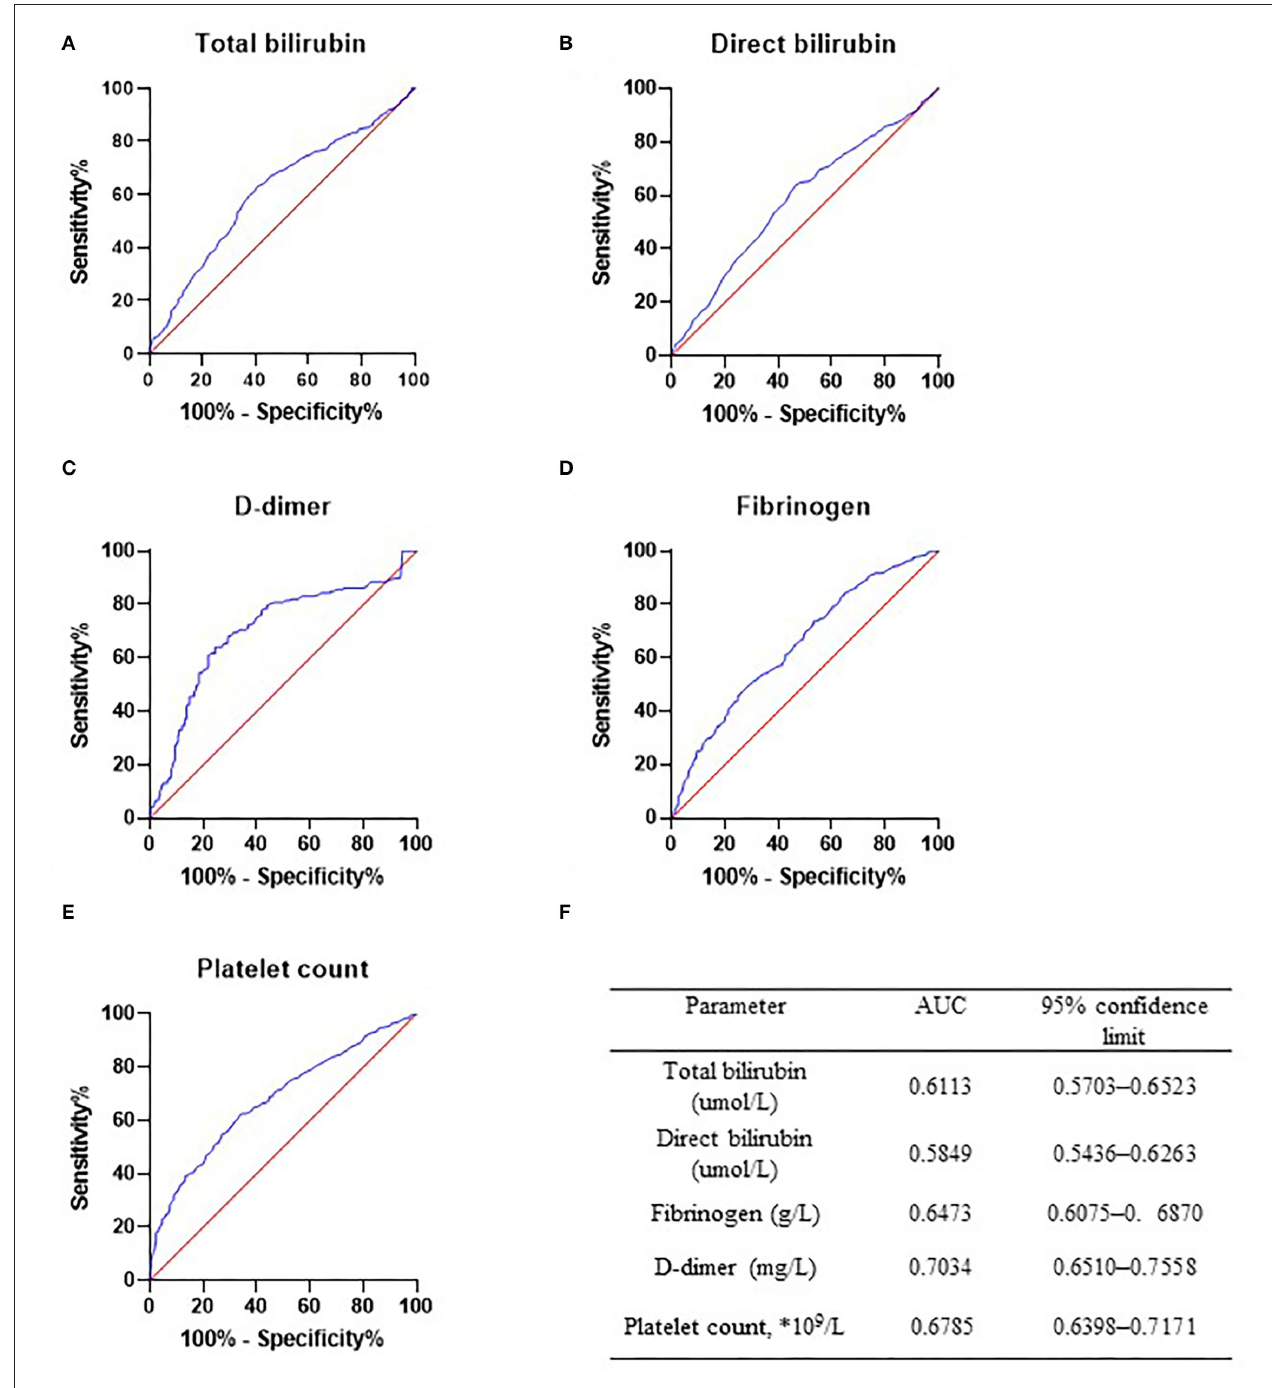
FIGURE 2 | Receiver operator characteristic curve in abdominal aortic aneurysm (AAA) group and peripheral arterial disease (PAD) group. Receiver operator characteristic curve of total bilirubin (A) , direct bilirubin (B) , D-dimer (C) , fibrinogen (D) , and platelet count (E) was drawn in PAD only and AAA only patients. Diagnostic efficacy of these markers was determined. (F) Detailed information of ROC curves. AAA, abdominal aortic aneurysm; PAD, peripheral arterial disease.